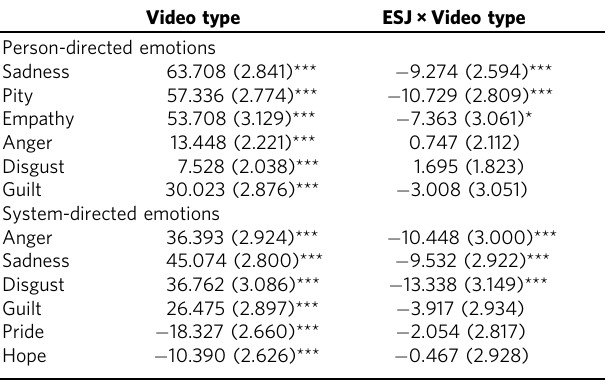
Supplementary Tables 29 – 34 for full regression results and Supplementary Figs. 13 – 18 for simpli fi ed interaction graphs.